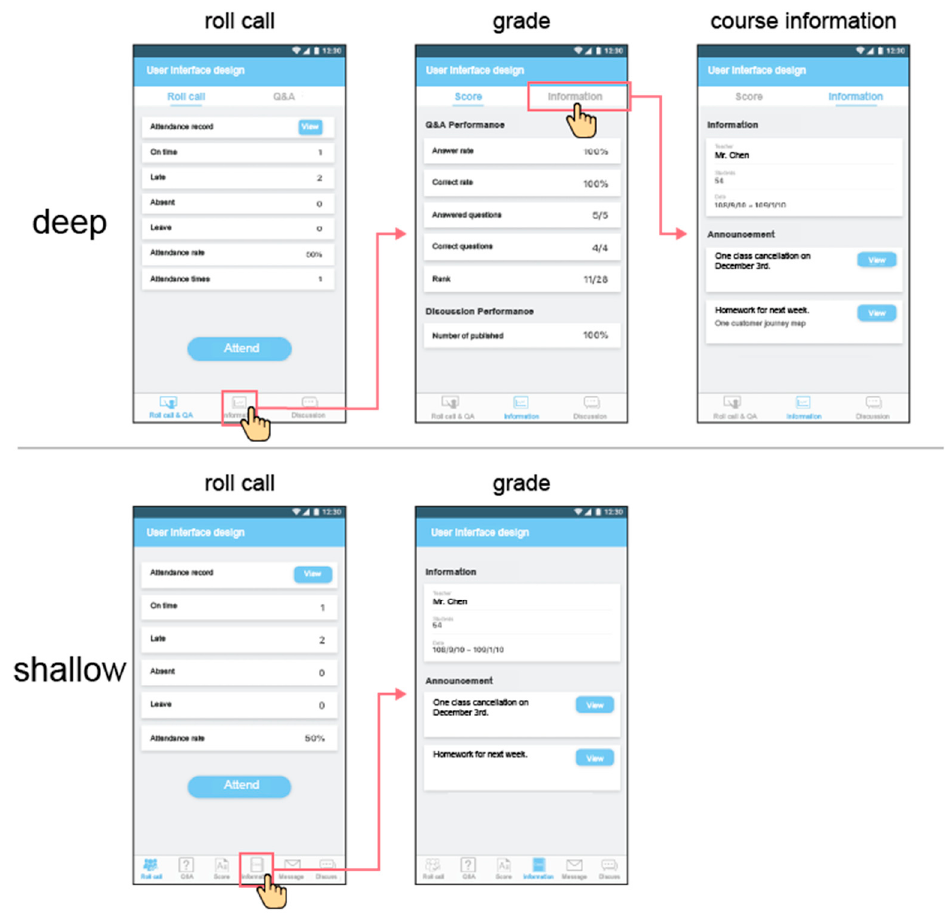
Figure 10. 3-3 Task page switching